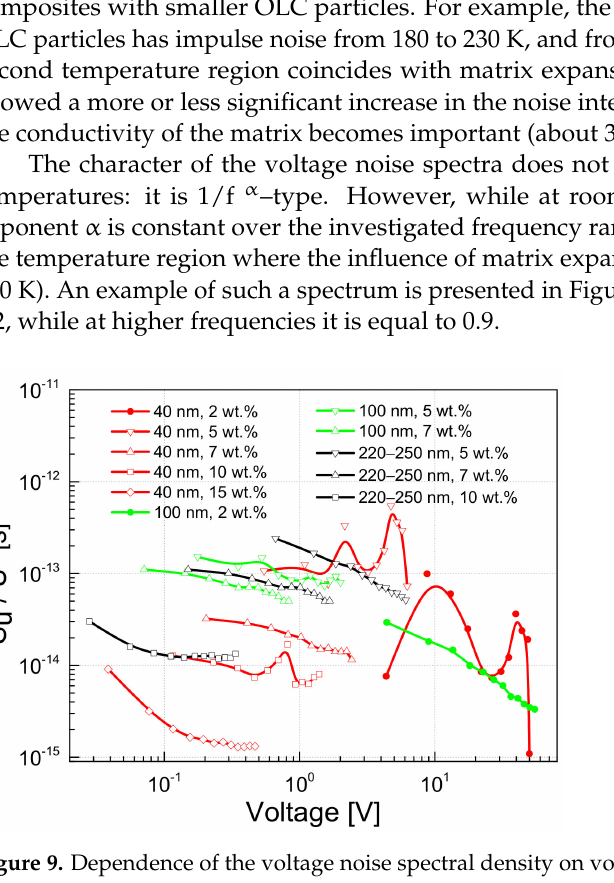
Figure 9. Dependence of the voltage noise spectral density on voltage for composites with different filler concentrations and different OLC particle sizes at 290